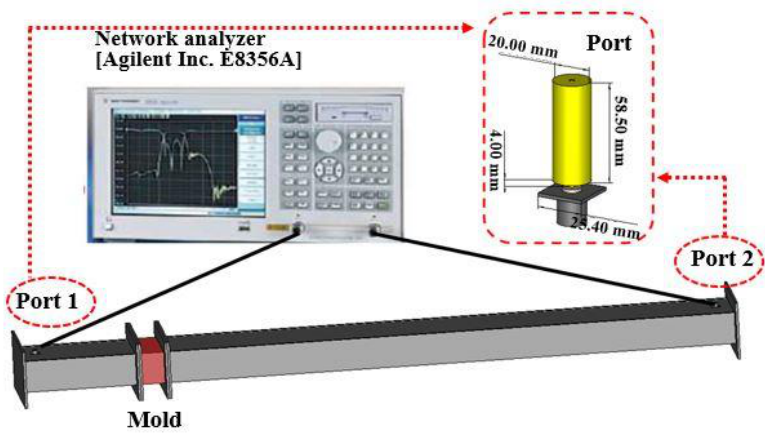
Figure 2. Experimental setup for electromagnetic shielding performance evaluation [42].